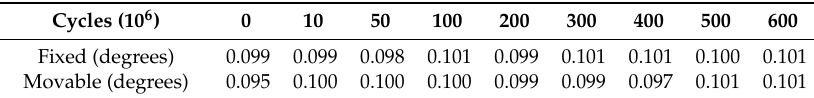
Table 5. The angle of the beam end.